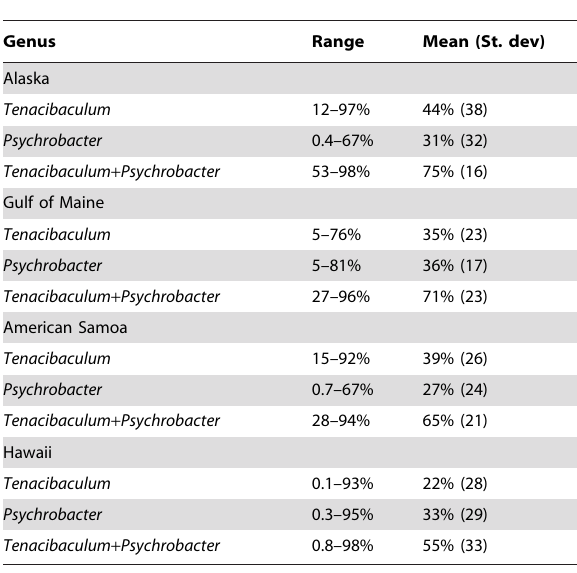
Table 3. Abundances of whale skin-bacterial sequences corresponding to the Tenacibaculum and Psychrobacter